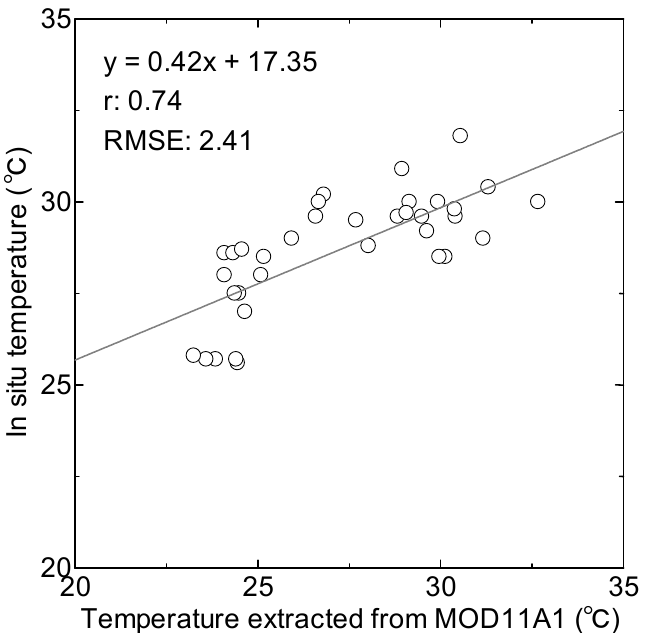
Figure 2. Comparison between the water temperatures extracted from MOD11A1 and in situ data.